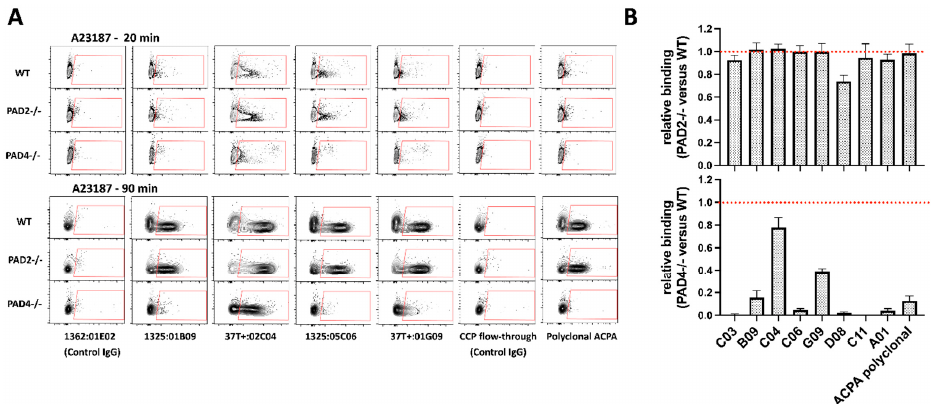
Figure 3. ACPA binding to PAD2- or PAD4-deficient neutrophils. Neutrophils were isolated from wild-type, PAD2- or PAD4-deficient mice, activated with A23187 and then fixed/permeabilized and stained with different ACPA and control antibody preparations. Representative stainings are shown with contour plots, with antibodies characterized by more or less PAD4-independent binding capacity ( A ). Average values are shown from at least three independent experiments ( B ). PAD4 deficiency resulted in a significant decrease in neutrophil binding ( p < 0.001 for all clones, except for C04 where p < 0.01).